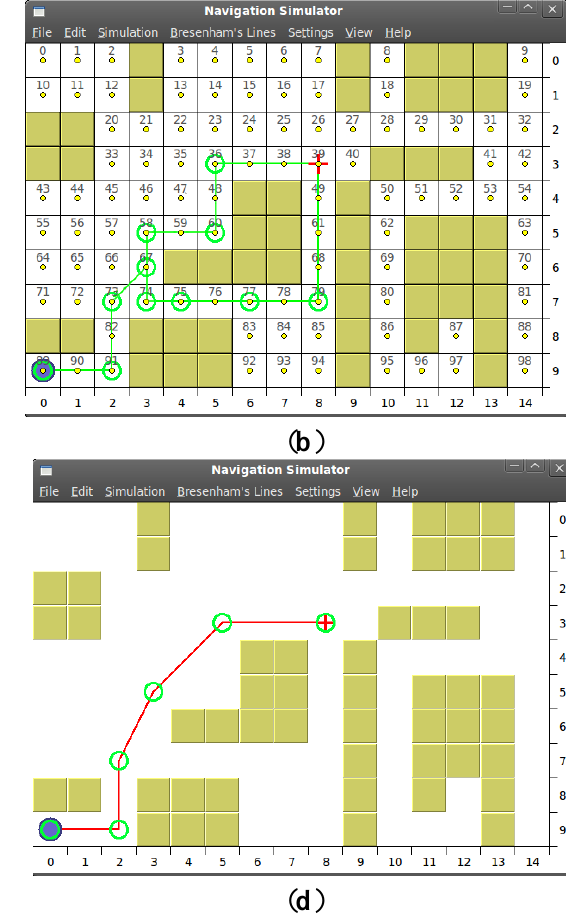
Figure 6. Full HCTNav case-study: ( a ) Initial map scenario; ( b ) Raw path-graph generated; ( c ) Optimized path-tree; ( d ) Shortest path